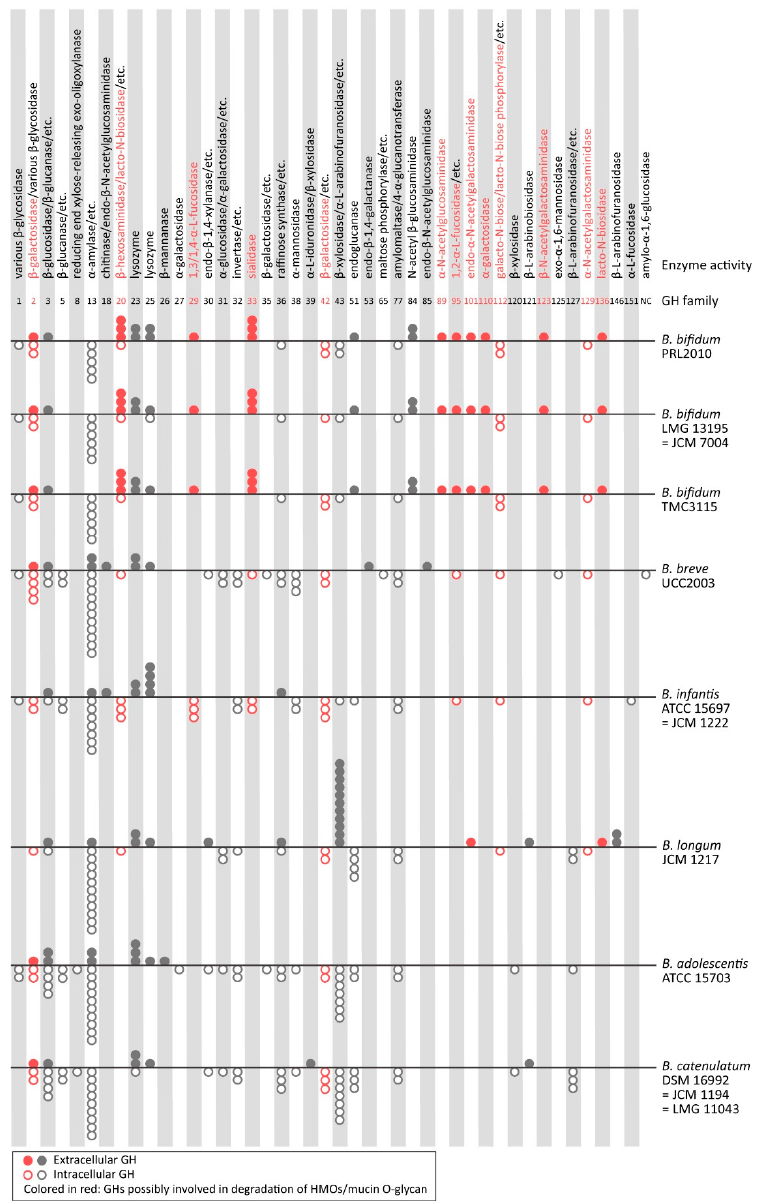
Figure 2. Distribution of glycoside hydrolases (GHs) and their cellular localization in the selected Bifidobacterium species/strains. The circles represent the occurrence of enzymes (domains) classified in the respective GH families in the CAZy database (http://www.cazy.org). The extracellular and intracellular enzymes are shown by solid and open circles, respectively. Protein localization was predicted by signalP-5.0 (http://www.cbs.dtu.dk/services/SignalP/) and TMHMM Server v. 2.0 (http://www.cbs.dtu.dk/services/TMHMM/). The pseudogenes that encode incomplete protein sequences are excluded from the analysis. The GHs that are (possibly) involved in the degradation of HMOs and mucin O -glycans are colored in red.